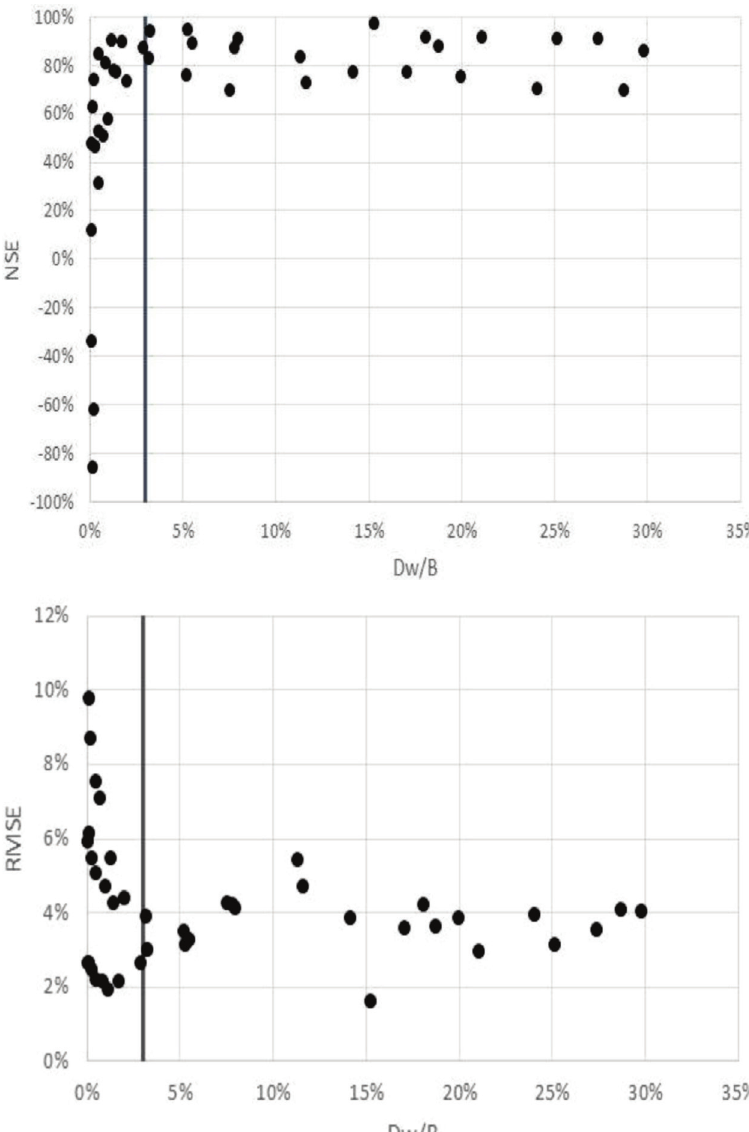
Figure 5. Performance of the entropy models as a function of the distance to the vertical wall. Each point refers to a measured vertical profile. The variable D W is the horizontal distance to the nearest wall and B is channel width. Vertical grey lines indicate the threshold of the model applicability (D /B > 0.03). (a) W Nash-Sutcliffe coefficient (NSE). (b) Root mean square error